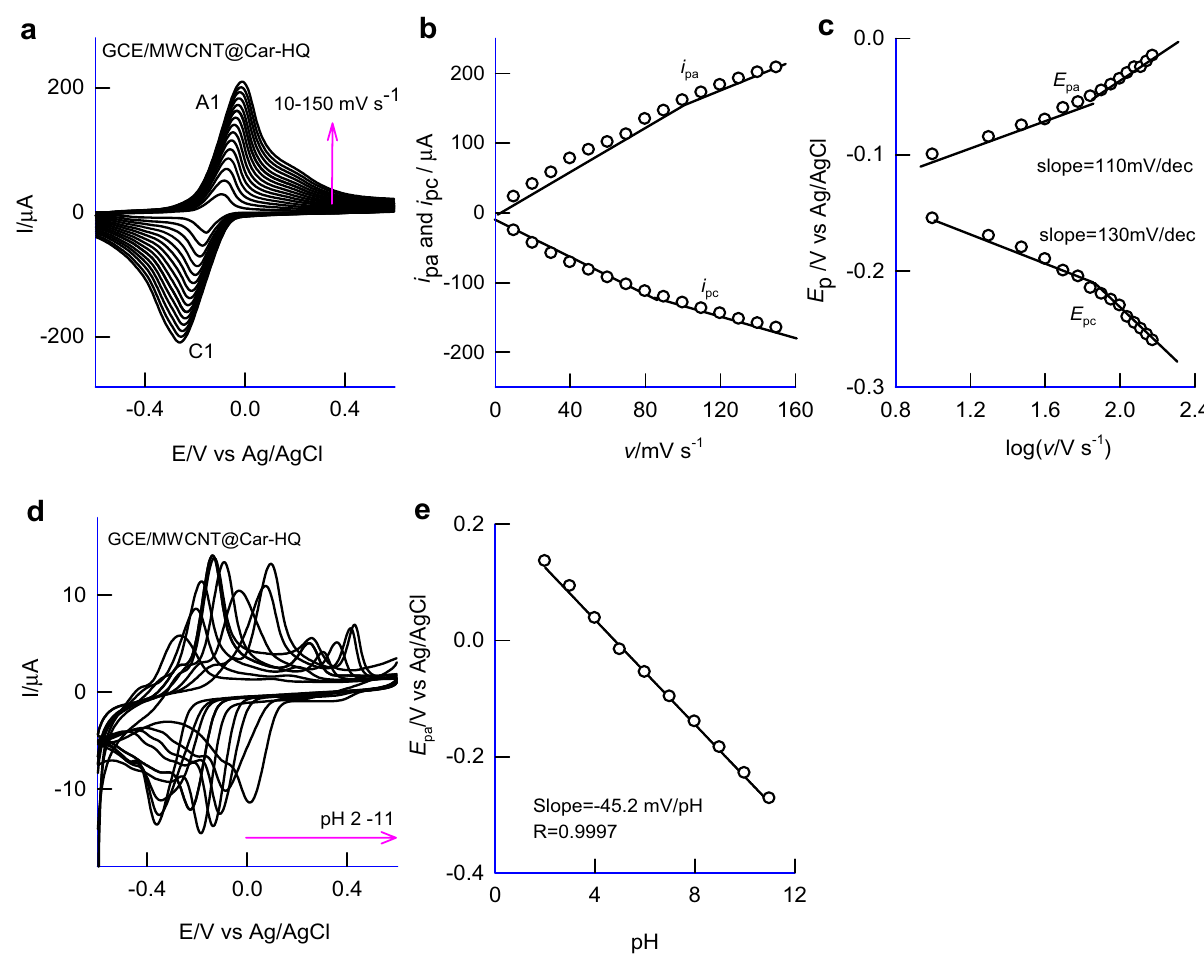
Figure 4. ( a ) CV response of GCE/MWCNT@Car-HQ at various scan rates, v = 10–150 mV s −1 in pH 7 PBS, ( b ) plot of ( i pa and i pc ) versus scan rate and ( c ) plot of ( E pa /V) versus log ( v /V s −1 ). ( d ) is the CV response of GCE/MWCNT@Car-HQ at different pHs and ( e ) its corresponding calibration